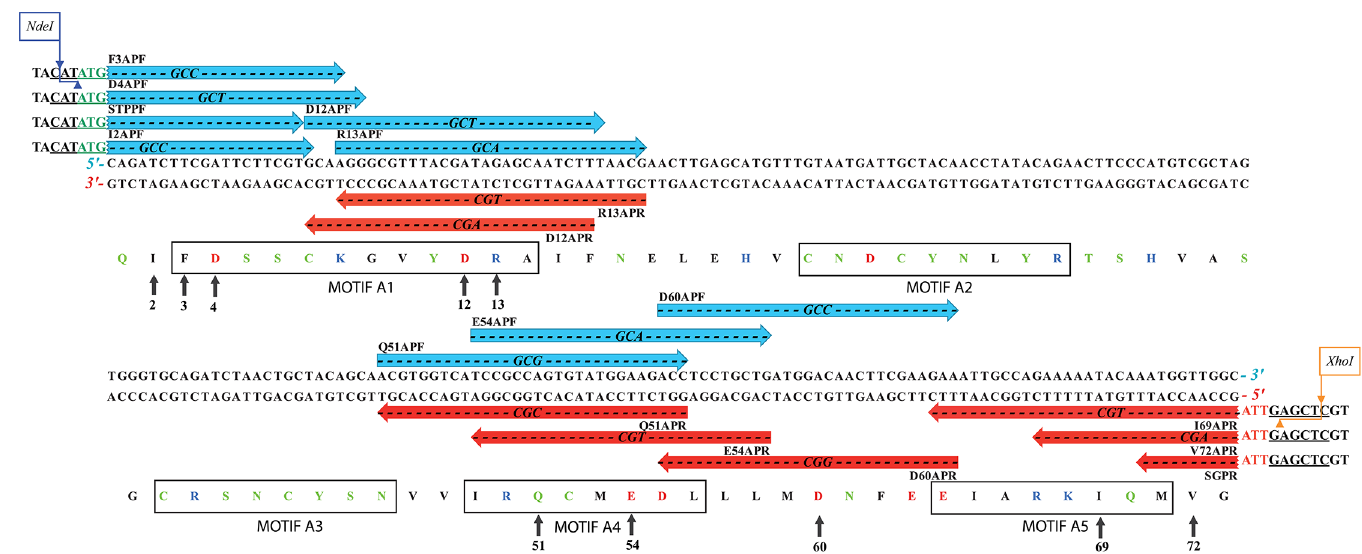
Fig 1. Location and sequence of the PCR primers used in the present study. DNA sequences (upper: sense strand; lower: anti-sense strand) encoding a glycine-extended version of the mature Sco-CHH (accession No. AAQ75760) are given. Forward (blue) and reverse (red) primers are placed above the sense strand and below the anti-sense strand, respectively. Nucleotide sequences of the primers identical to those of the Sco-CHH sequence are indicated by bold dash line (----), with the alanine-encoding codons in the forward primers (GCC, GCT, GCA, or GCG) and in the reverse primers (GGC, AGC, or TGC) shown in italics. NdeI recognition sequence (CATATG) containing a methionine-encoding start codon (ATG, shown in green) was included in the forward primers STPPF, I2APF, F3APF, D4APF; XhoI recognition sequence (CTCGAG) was included in the reverse primers SGPR, I69APR, V72APR, followed by a stop codon (TTA shown in red) and a glycine-encoding codon GCC. Amino acid sequence of the glycine-extended Sco-CHH is also shown. CHH motifs as defined by Lacombe et al. [30] are boxed. Residues for which alanine was substituted in the present study are pointed by arrows and the residue numbers